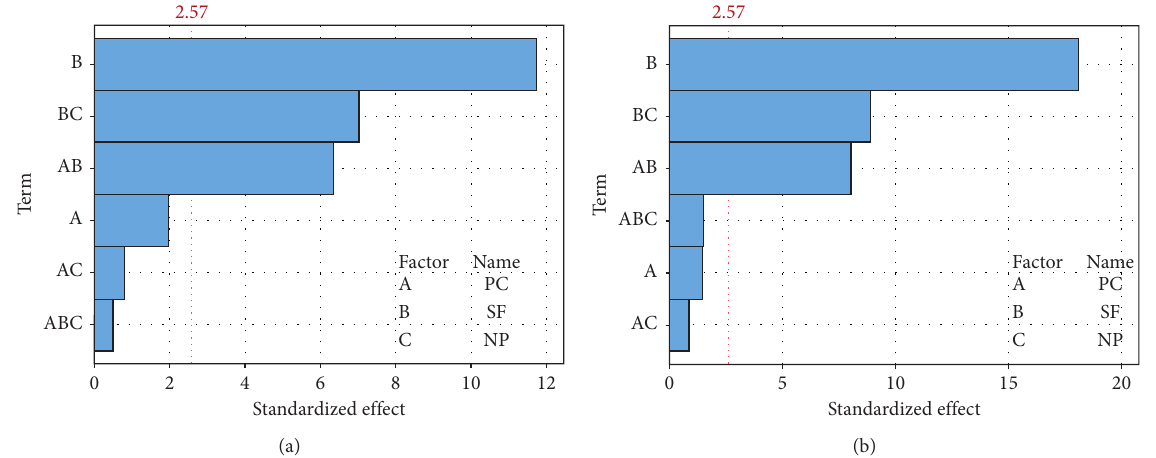
Figure 7: Pareto chart of permeability standardized effects ( α � 0.05). (a) ( w / b ) � 0.25. (b) ( w / b ) � 0.40.